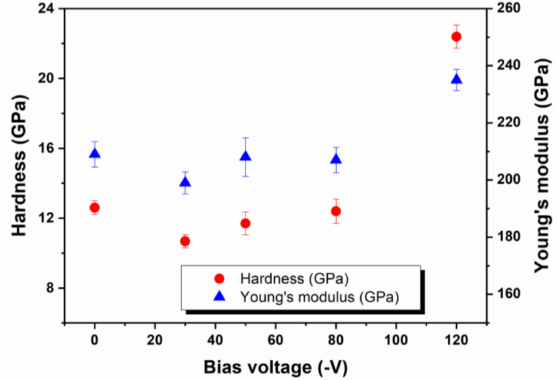
Figure 7. Hardness and Young’s modulus of the Ta films deposited by DOMS with di ff erent bias